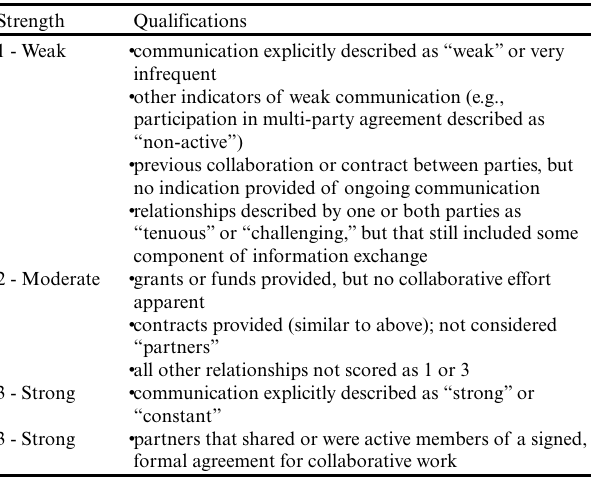
Table 2 . Characteristics of the different strengths assigned